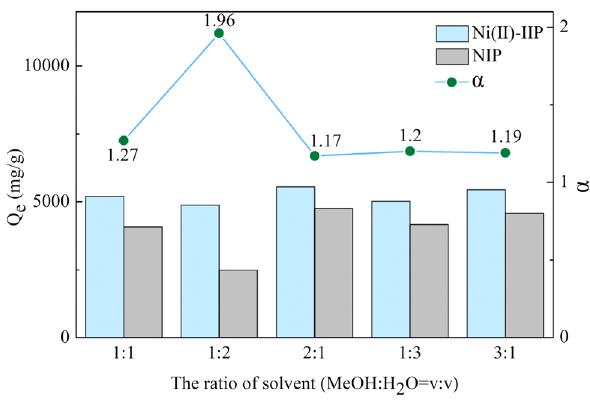
Figure 2: E ff ect of the ratio of solvent on adsorption